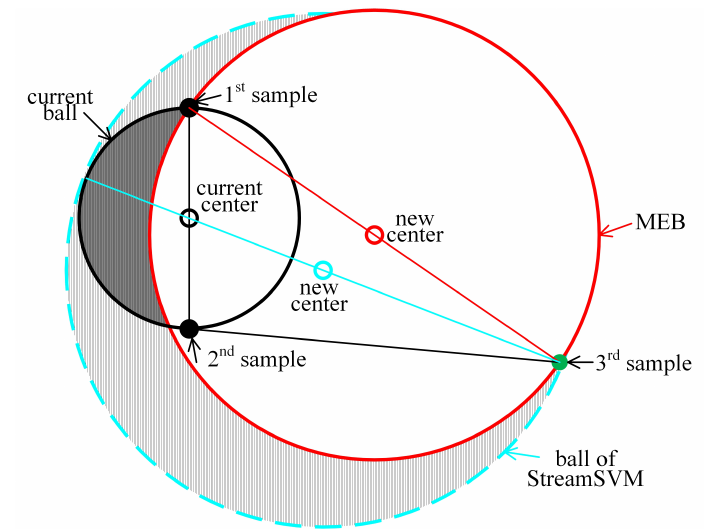
Figure 2. Motivation from StreamSVM [16] in learning the